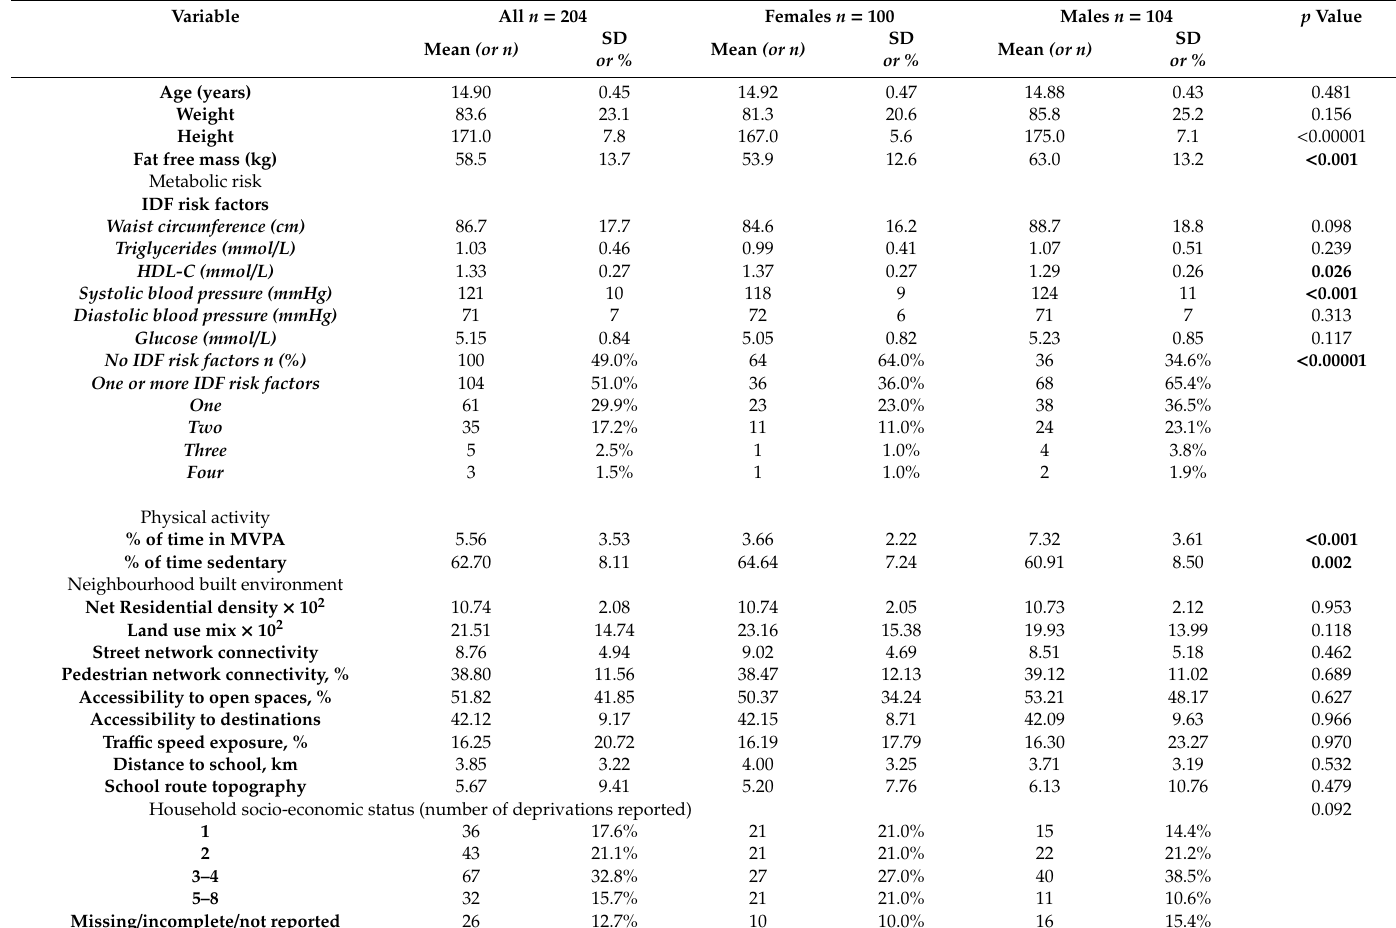
Table 1. Participant and neighbourhood